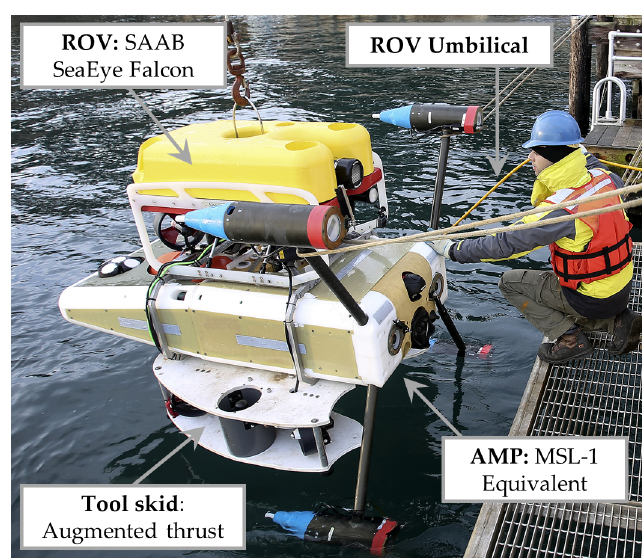
Figure 12. ROV deployable version of AMP tested prior to MSL-1. The ROV delivered the AMP to a pre-placed, cabled docking station (frame in Figure 4), engaged a wet-mate power and fiber connector (Teledyne ODI NRH), and then returned to the